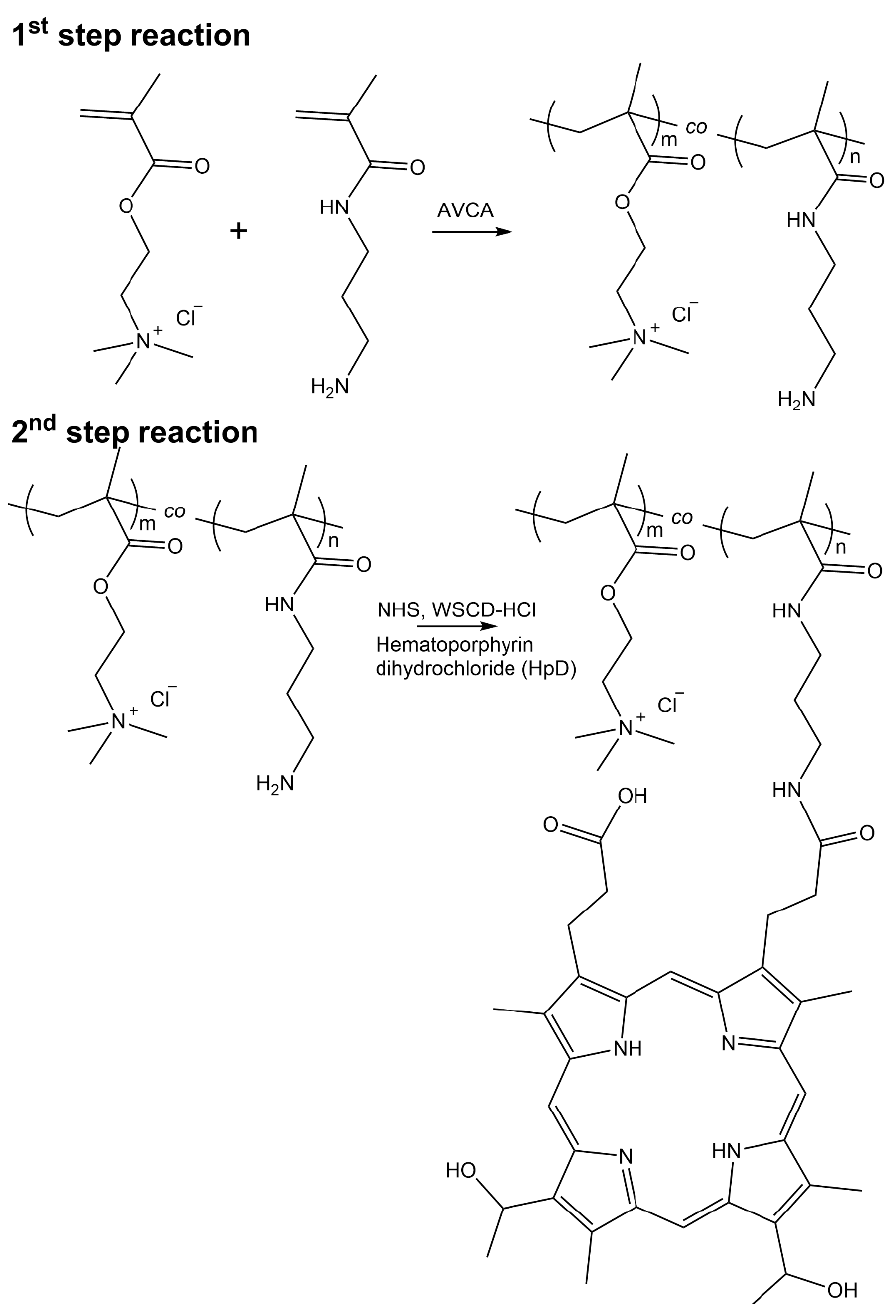
Figure 1. Synthesis scheme of PMETAC- co -PAMPAA(HpD). From the size exclusion chromatography (SEC) profile, the number- and weight-av- erage molecular weights of the obtained polymer, PMETAC- co -PAPMAA, were 23,500 and 54,500, respectively, and its polydispersity index (PDI) was 2.32 (Figure 2A).